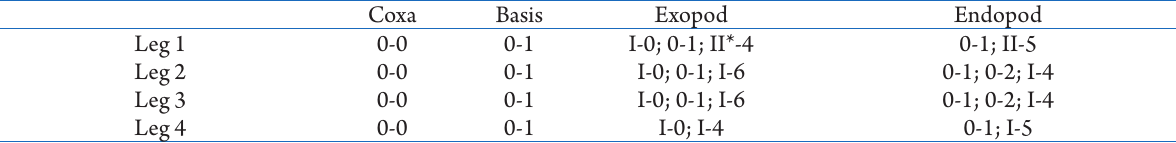
Table 1. Ergasilus turkayi n. sp., armature of legs (setae, Arabic numerals; spines, Roman